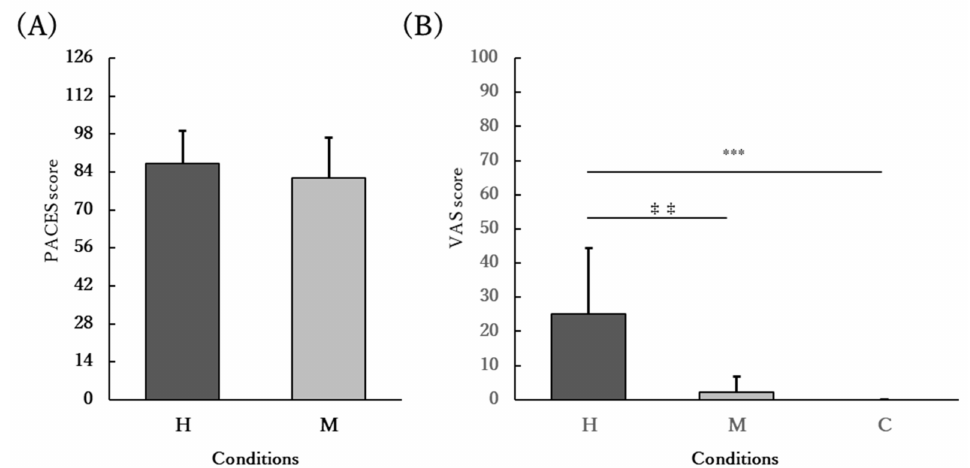
Figure 4. ( A ) PACES and ( B ) VAS for nausea. The participants performed 11 min of home-based HIIE 30 min after a meal in the H condition (H), 30 min of moderate-intensity exercise 30 min after a meal in the M condition (M), and 30 min of seated rest 30 min after a meal in the C condition (C). ( A ) The mean PACES value was not significantly different between the H and M conditions ( p = 0.287). ( B ) The mean VAS score was significantly higher in the H condition than in the M and C conditions ( p < 0.001). ‡‡ p < 0.01 vs. M; *** p < 0.001 vs. C. Abbreviations: PACES, Physical Activity Enjoyment Scale; VAS, visual analog